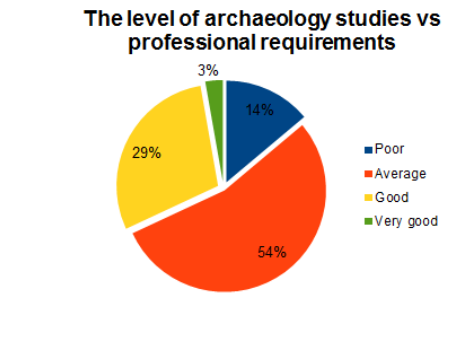
Figure 20 - The studies of archaeology versus professional requirements